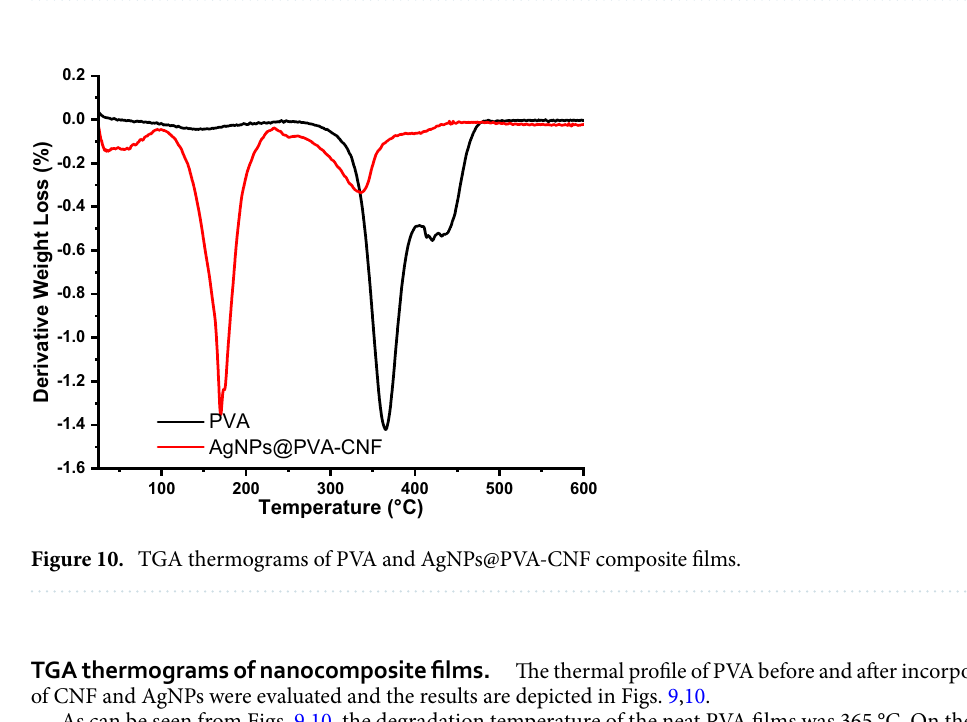
Figure 9. TGA thermograms of PVA and AgNPs@PVA-CNF composite films.